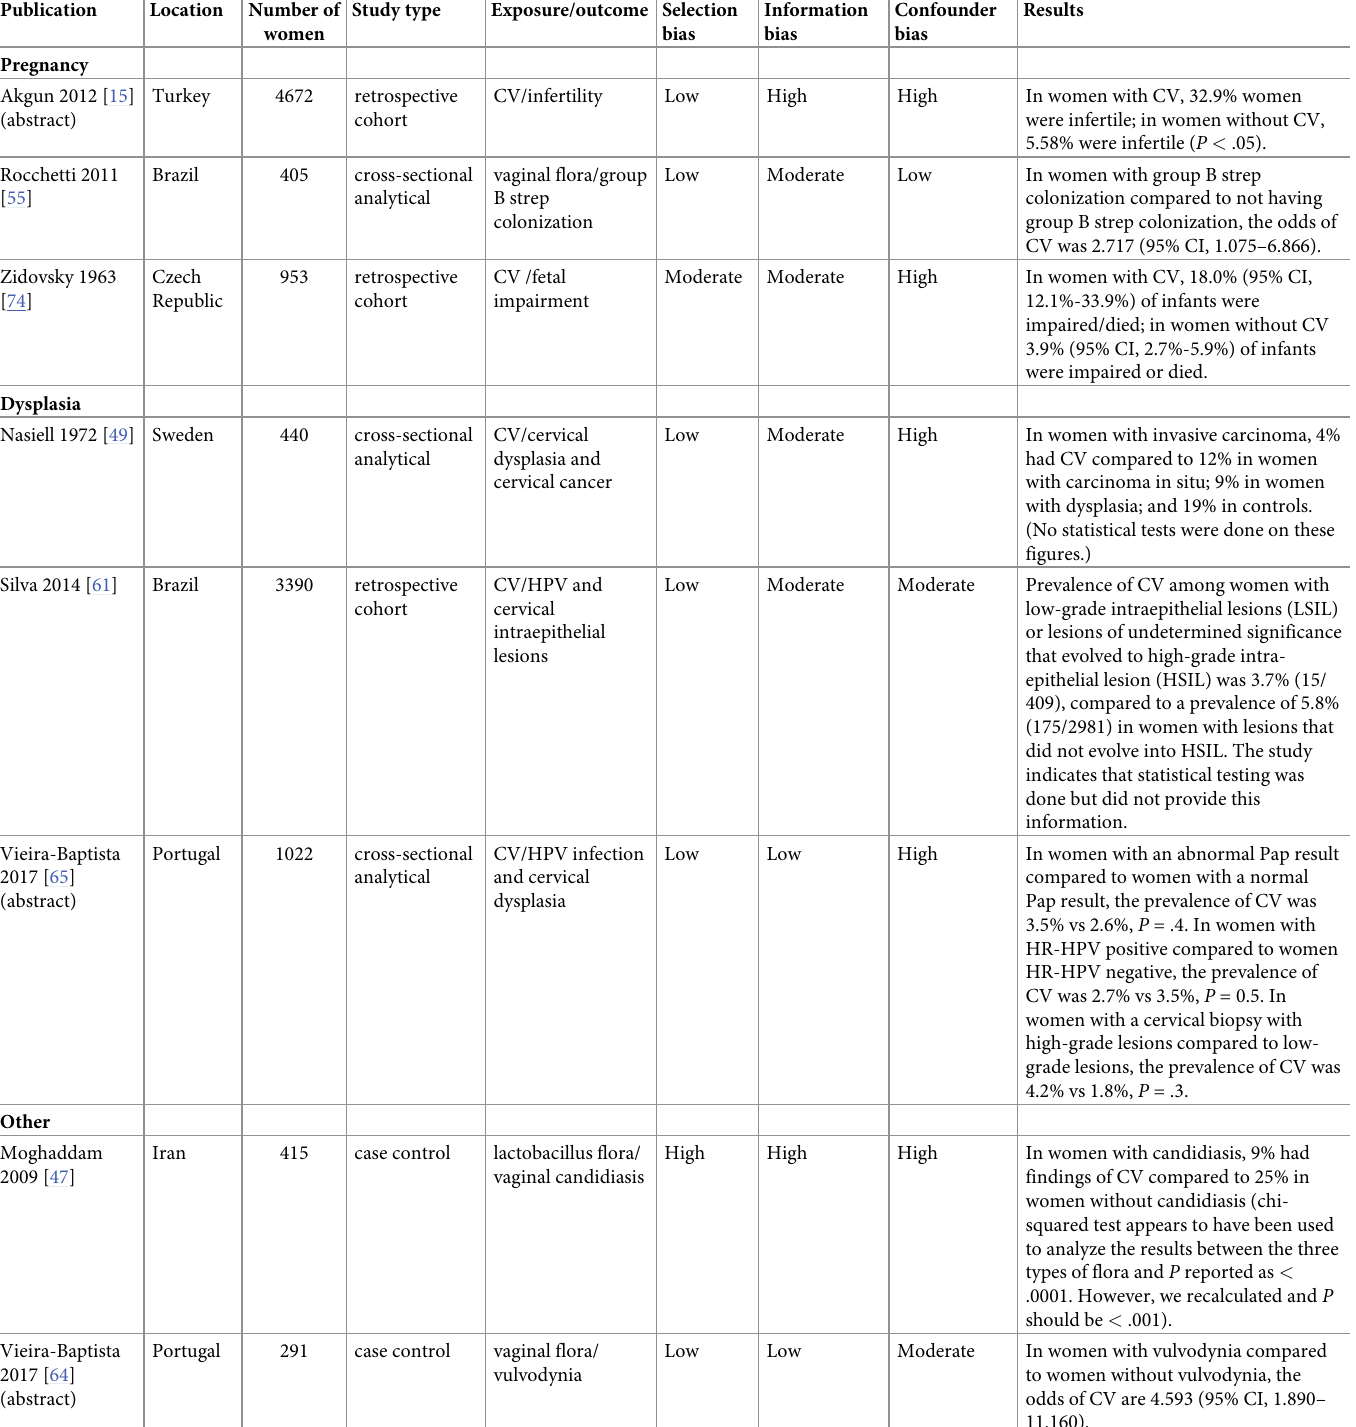
Table 6. Association between CV and other conditions (n = 8